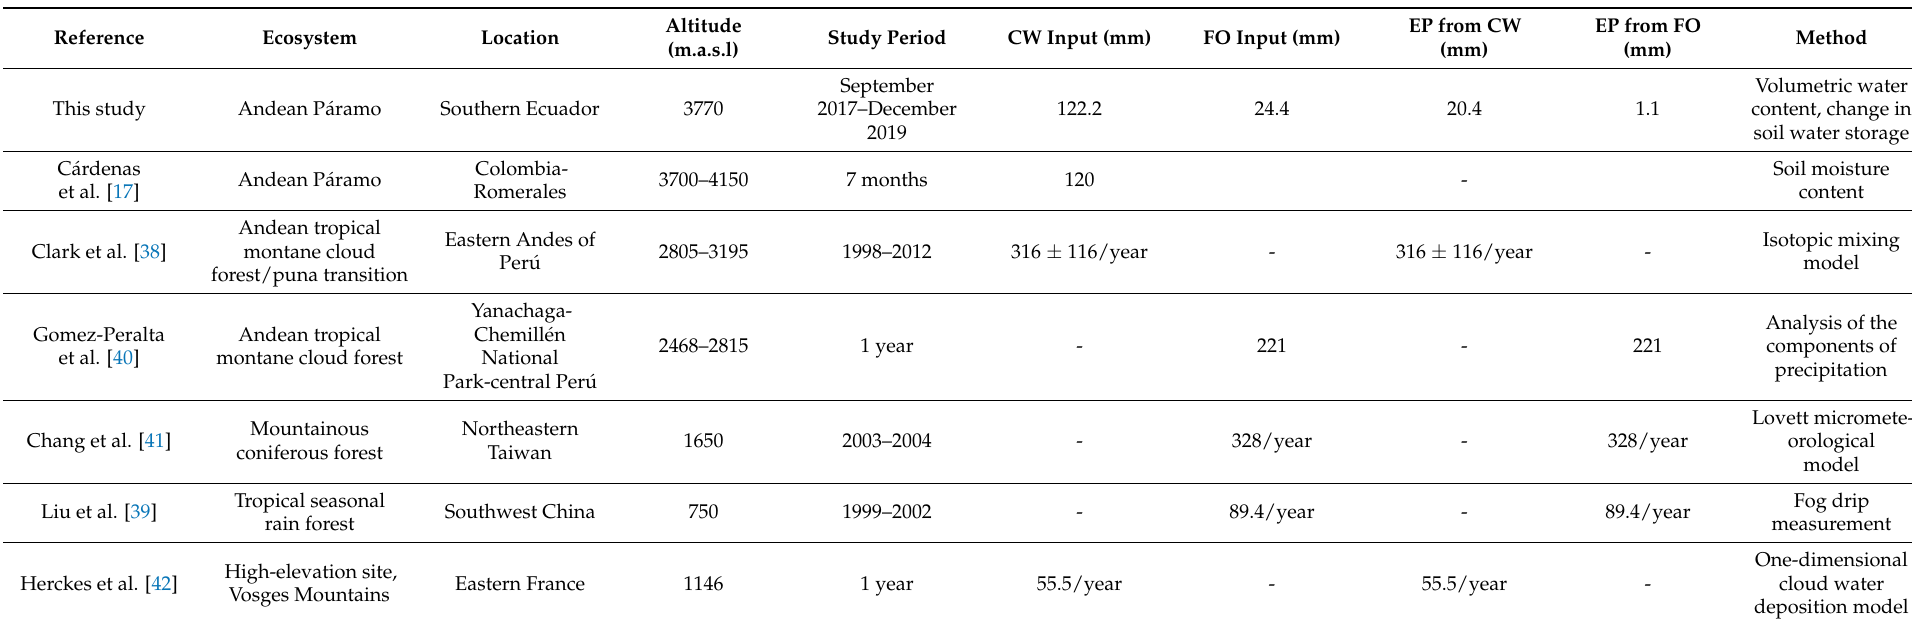
Table 2. Studies of fog and cloud-water deposition in ecosystems with different types of vegetation around the